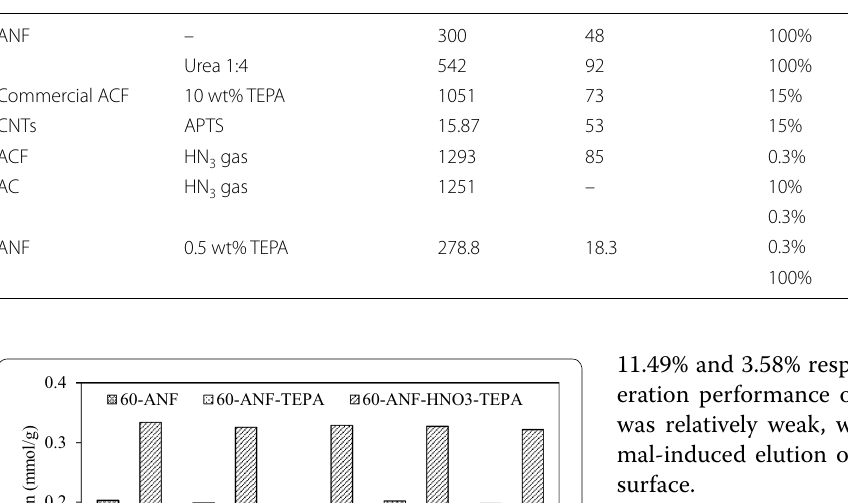
Table 6 Comparison of the CO adsorption capacities (q) of the current work with those from literature 2 Support Modification chemicals